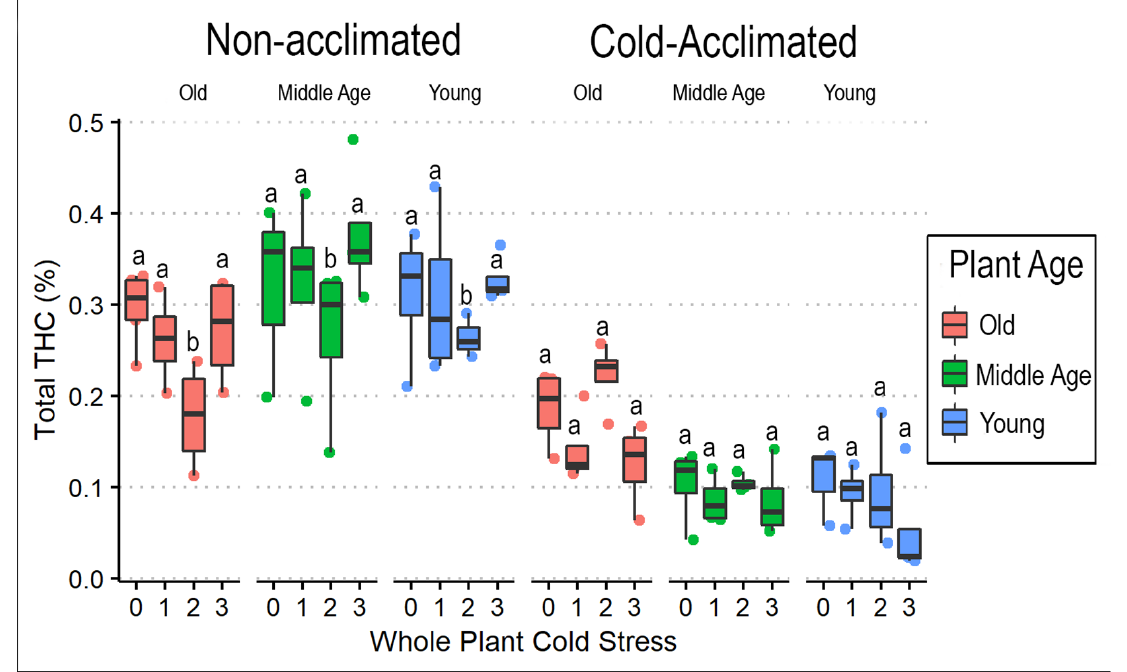
Figure 8. Total THC (%) box plots comparing whole-plant cold stress to acclimation treatment and plant age in ‘AutoCBD’. Data represent the percentage of THC added to the product of the percentage of THCA multiplied by the cannabinoid’s molecular weight ratio (0.878). Plants receiving cold acclimation treatment were subject to 10 days at 10 °C. Whole-plant cold stress consisted of a control treatment receiving no cold exposure, 0 (control); a single 3 h − 0.5 °C exposure, 1 ; two consecutive 3 h − 0.5 ◦ C exposures separated by 24 h, 2 ; and three 3 h − 0.5 ◦ C exposures separated by 24 h, 3 . Plant age treatments include oldest plants, middle-age plants, and youngest plants (68, 54, and 40 days old on the day of whole-plant cold stress, respectively). Letters indicate differences amongst consecutive cold exposures between cultivars, plant age, and acclimation. Lowercase letters indicate significant differences ( p < 0.05) between treatments (Tukey’s